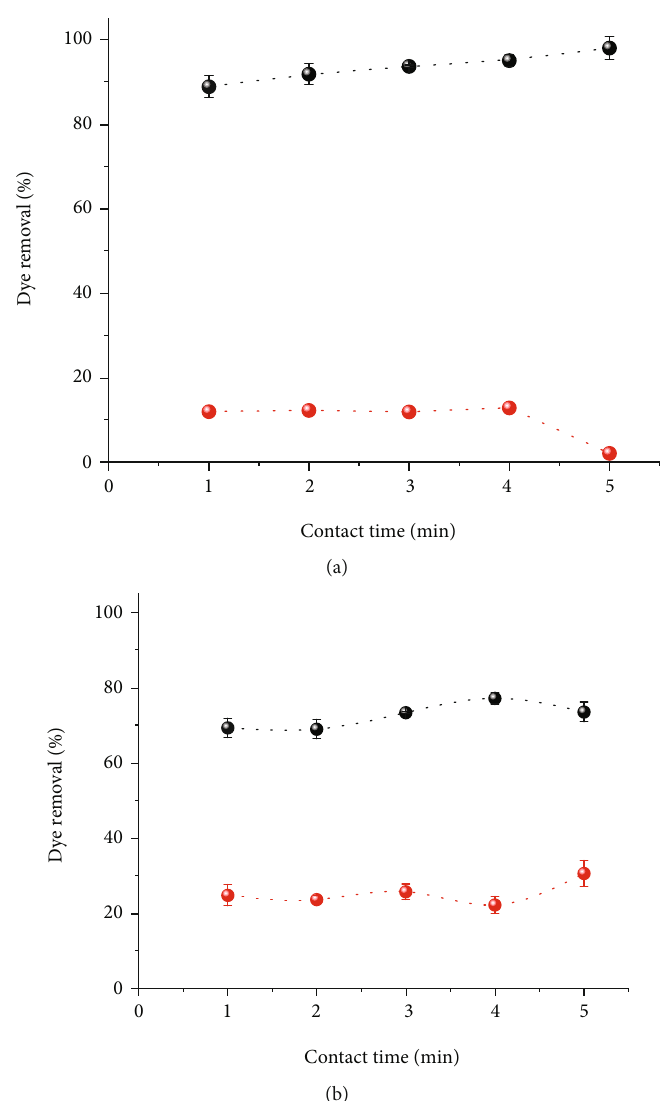
Figure 4: E ff ect of contact time on dye removal percentage: (a) MO ( pH = 4 , T = 25 ° C , amount of adsorbent 10 mg) and (b) XO ( pH = 4 , T = 25 ° C , amount of adsorbent 20 mg) by LCFA (red symbol) and LCFA-APTES (black symbol). The error bars represent the standard deviation calculated from at least three repeated measurements for each contact